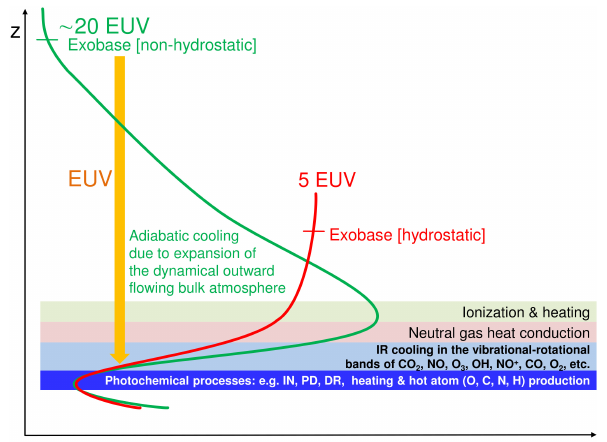
Fig. 1. Illustration of the thermospheric temperature response to high solar/stellar EUV flux. Enhanced ionization (IN) and photo- chemical processes like photo-dissociation (PD) and dissociative re- combination (DR) eventually lead to heating and subsequent expan- sion of the upper atmosphere and to the production of suprathermal atoms which may influence the energy balance in the thermosphere. Depending on atmospheric species and energy deposition, upper at- mospheres can switch from hydrostatic (Kulikov et al., 2007) to hydrodynamic regimes (Tian et al.,